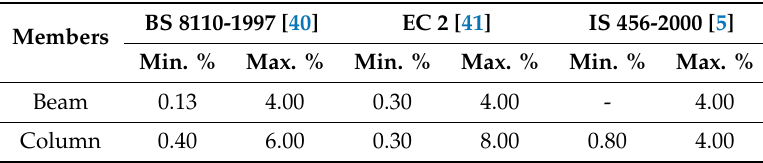
Table 5. Minimum and maximum percentage of steel